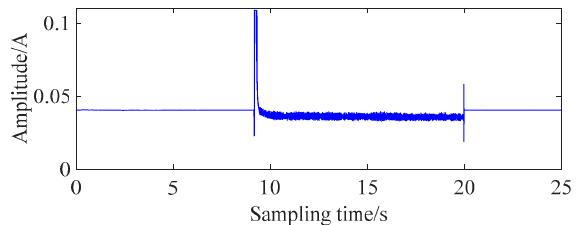
Figure 4. Signal of start-timeout fault.